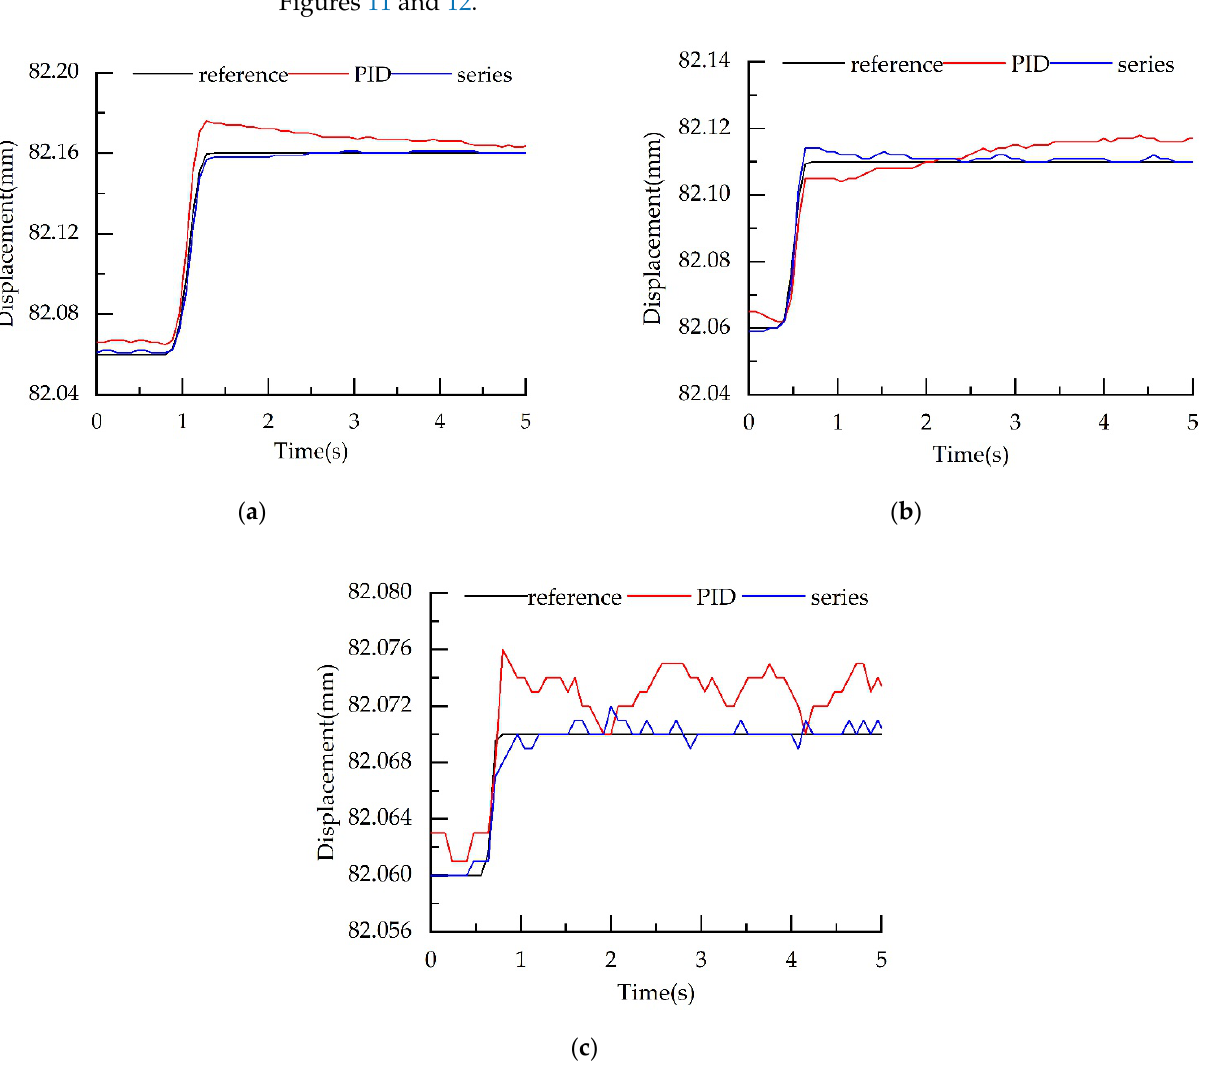
Figure 11. Displacement tracking curve. ( a ) Displacement 0.1 mm; ( b ) displacement 0.05 mm; ( c ) displacement 0.01 mm.